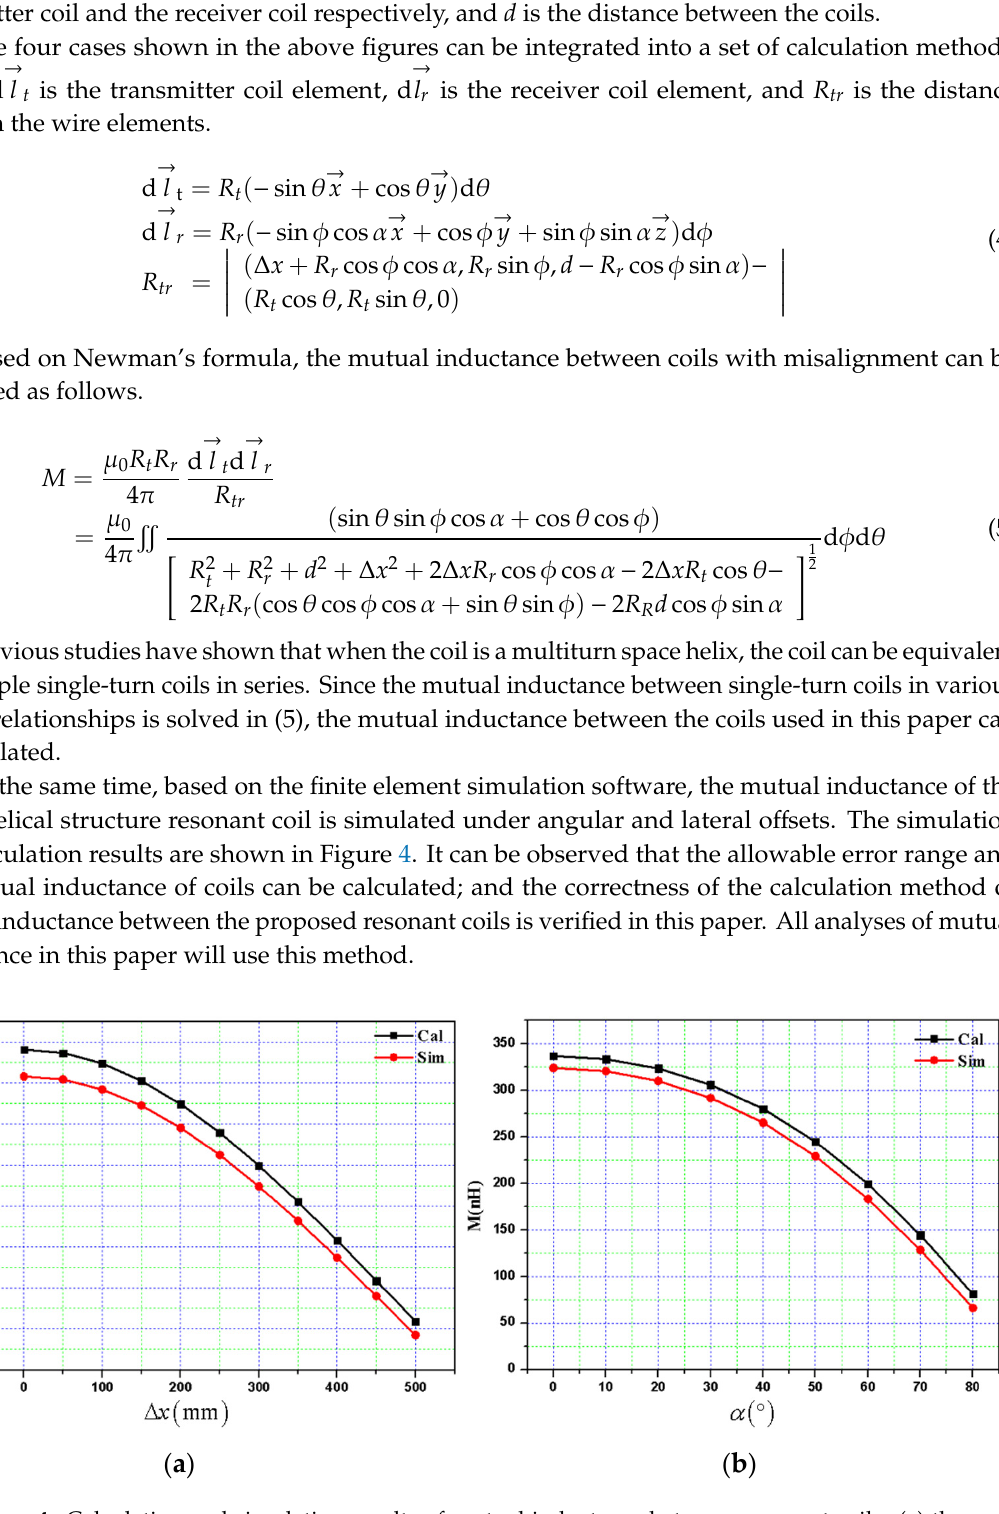
Figure 4. Calculation and simulation results of mutual inductance between resonant coils: ( a ) the relationship between mutual inductance and lateral offset, and ( b ) mutual inductance with the variation of angle.